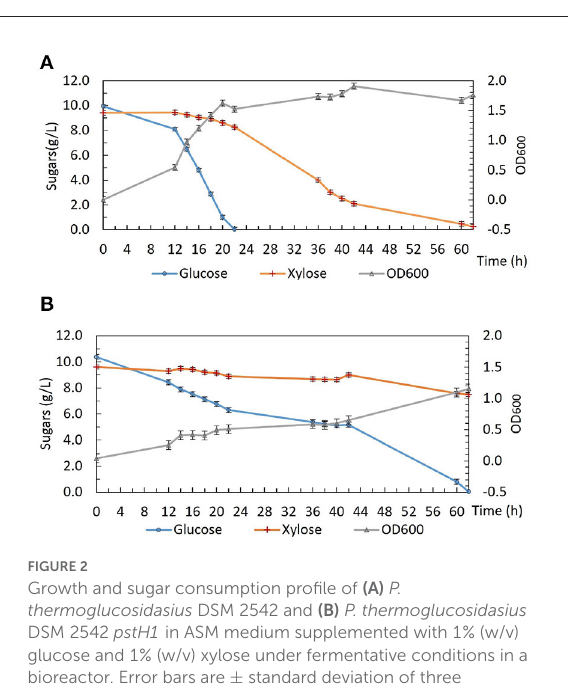
FIGURE3 Growth and sugar consumption profile of (A) wild type P. thermoglucosidasius DSM 2542 and (B) P. thermoglucosidasius DSM 2542 pstH1 in ASM medium supplemented with 0.5% (w/v) glucose and 0.5% (w/v) xylose under aerobic conditions. Two biological repeats are displayed in each graph using solid and dotted lines, respectively. Error bars are ± standard deviation of three technical replicates taken at the same time